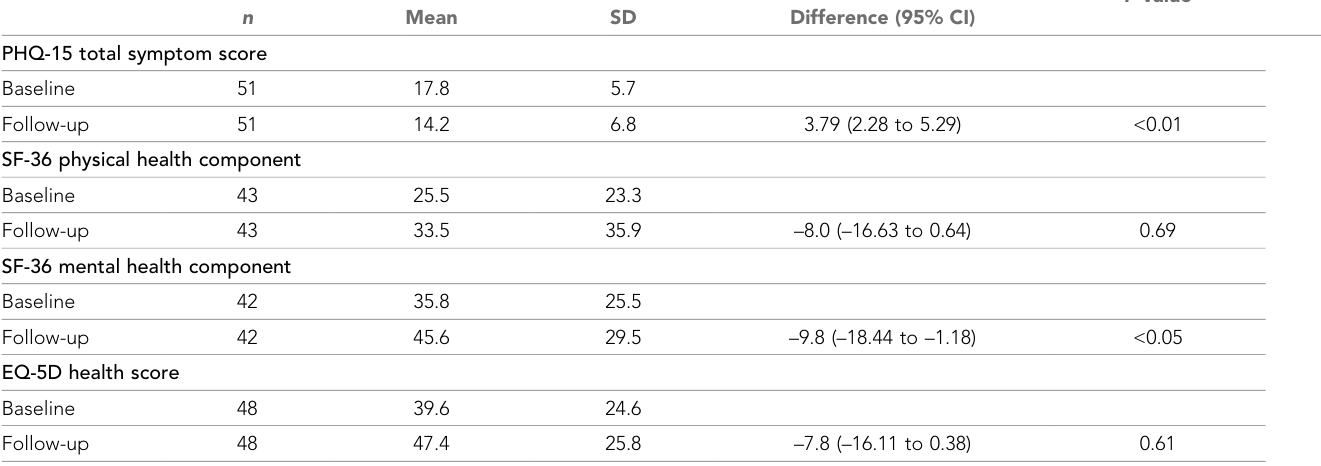
Table 2. Clinical baseline and follow-up comparison of somatic complaints and quality-of-life scores, using paired samples t -tests.